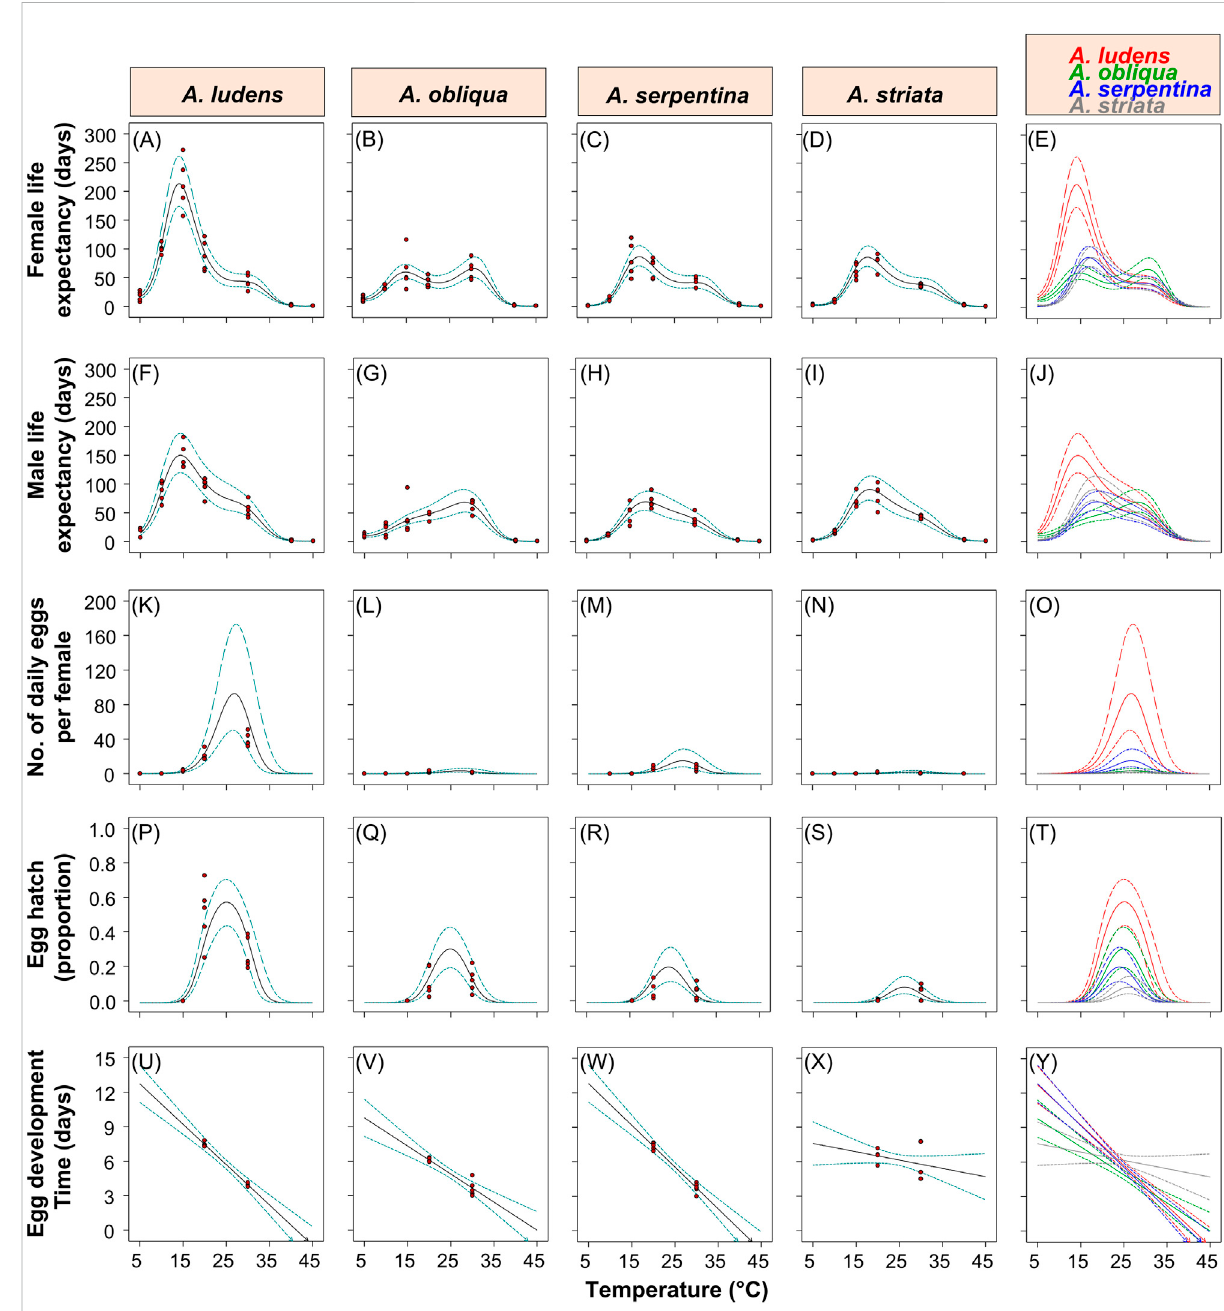
FIGURE 4 Polynomial models fi tted to data on female (A – E) and male (F – J) life expectancy, the estimated daily egg production per female (K – O) , egg hatch (P – T) and egg development time (U – Y) of four Anastrepha species (from left to right A. ludens , A. obliqua , A. serpentina and A. striata ) in response to an extreme increase in temperature. Solid lines indicate the models fi tted to the data, and the dotted lines the 95% con fi dence intervals. Red points indicate the data points to which the models were fi